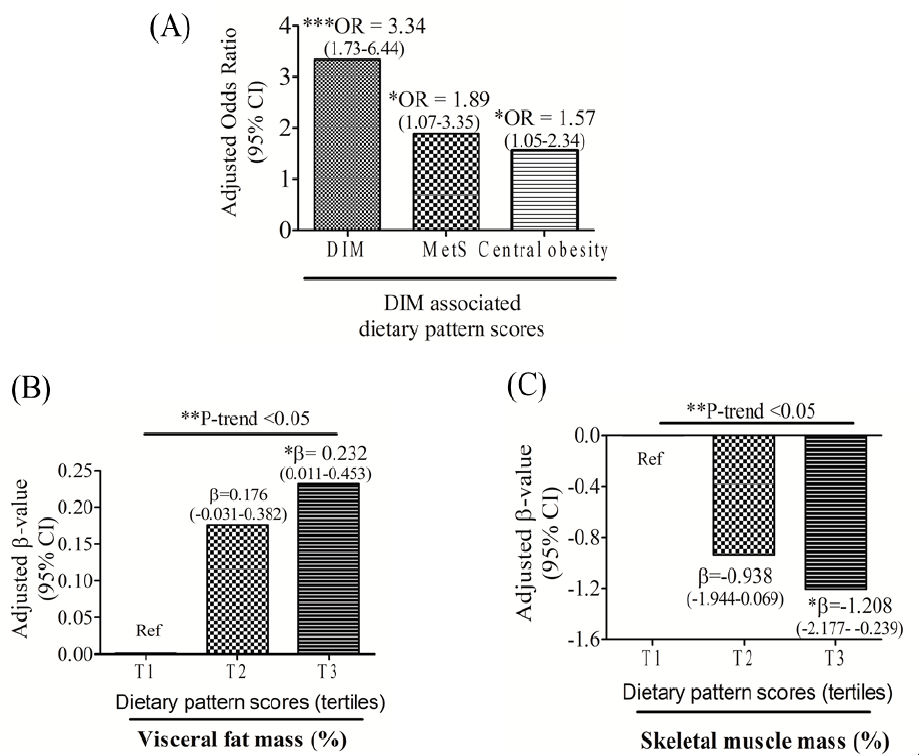
Figure 3. Multivariate logistic analysis adjusted for age, gender, and body-mass index and linear regression and 95% confidence intervals (CIs) of dysregulated iron metabolism (DIM)-associated dietary pattern scores for predicting DIM ( A ), metabolic syndrome (MetS) ( A ), central obesity ( A ), visceral fat mass (%) ( B ), and skeletal muscle mass (%) ( C ). * p < 0.05; ** p < 0.01; *** p ≤ 0.001.